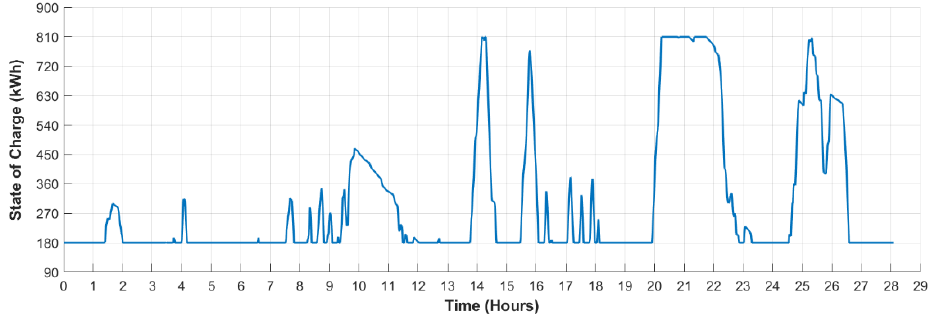
Figure 10. Energy accumulation (considering storage limits).